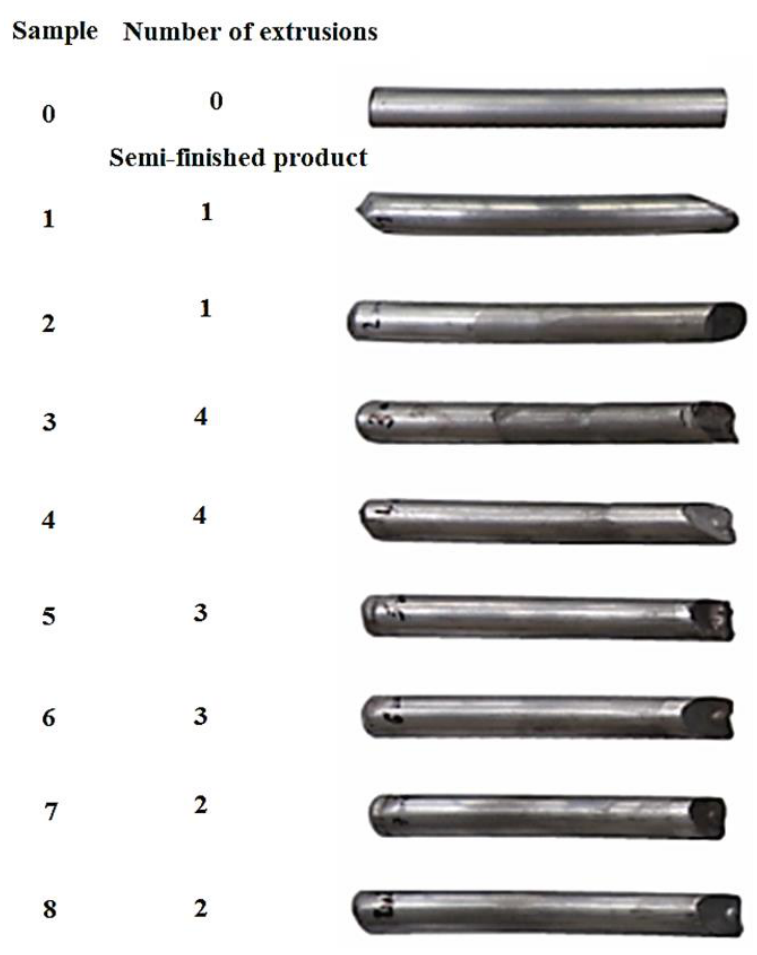
Figure 5. Sample set prepared by the ECAP method.